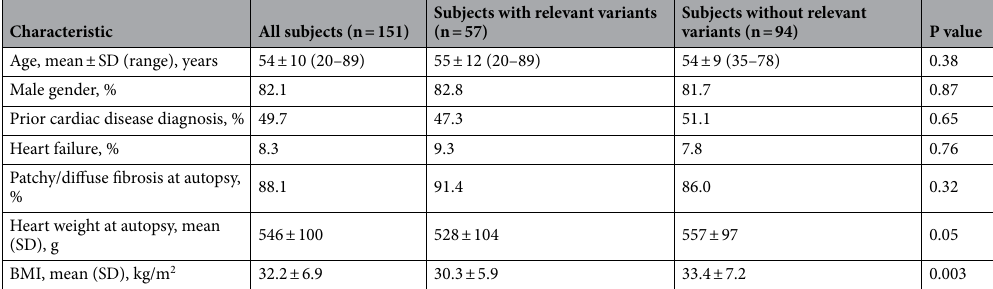
Table 2. Characteristics of the study subjects classified by the presence of rare gene variants (likely pathogenic or variants of uncertain significance). BMI body mass index, SD standard